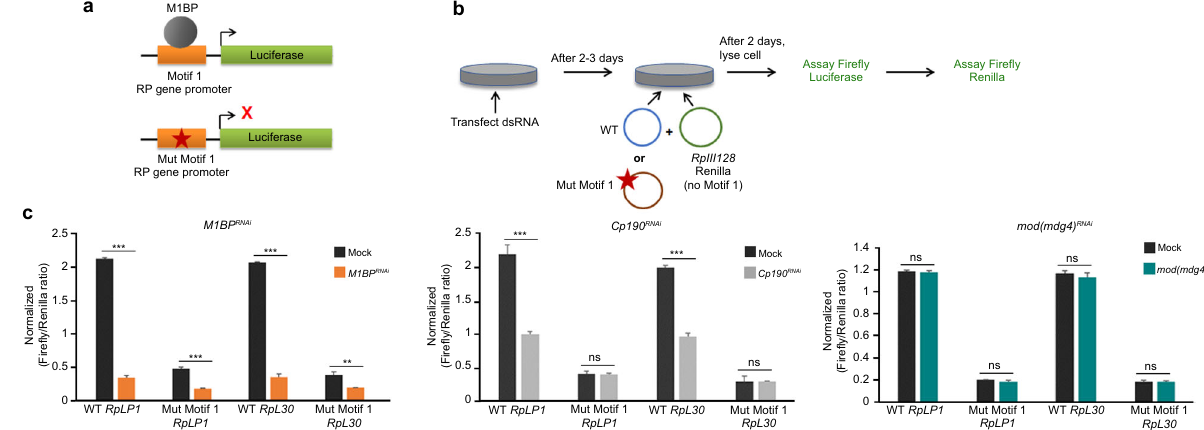
Fig. 5 M1BP and CP190 both activate Motif 1-containing gene promoters. a Schematic diagram of plasmids containing wild-type and Motif 1 mutants of ribosomal protein (RP) gene promoter driving luciferase reporters. b Schematic diagram showing RP gene luciferase reporter assay. RpIII128 promoter lacks Motif 1 and serves as a transfection control. c Fire fl y/Renilla luciferase ratio of relative light unit measurements. Experiments are performed in indicated knockdown conditions. Data represented as mean ± SD from n = 3 biological replicates, and P values were analyzed by two-tailed unpaired t -test. WT RpLP1 Mock vs M1BP RNAi ; Mut Motif 1 RpLP1 Mock vs M1BP RNAi ; WT RpLP30 : Mock vs M1BP RNAi ; WT RpLP1 Mock vs Cp190 RNAi ; and WT RpLP30 Mock vs Cp190 RNAi all P = 0.0001, Mut Motif 1 RpLP30 Mock vs M1BP RNAi P = 0.0017, Mut Motif 1 RpLP1 Mock vs Cp190 RNAi P = 0.73, Mut Motif 1